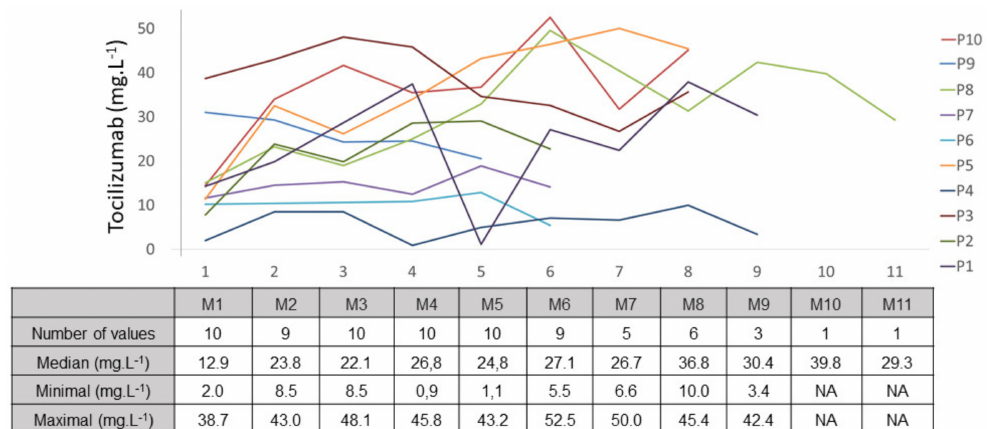
Figure 1. Temporal evolution of tocilizumab trough concentration. NA: not applicable, M: month after the first infusion of